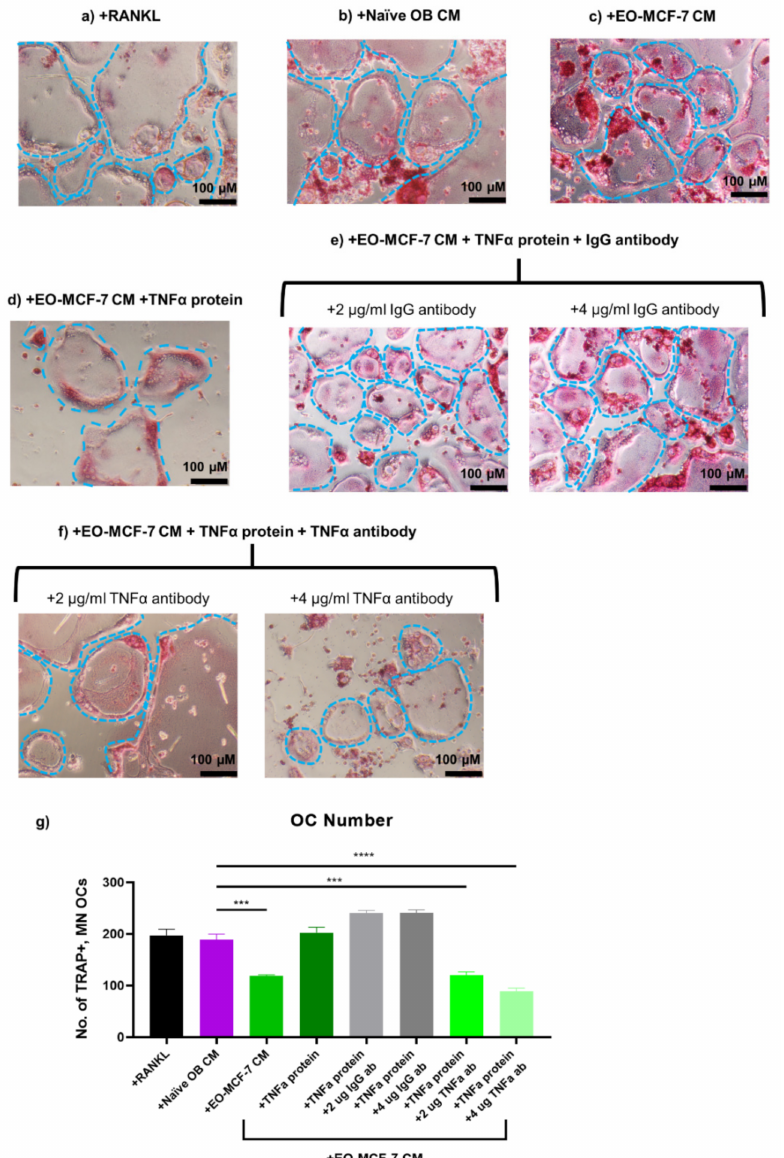
Figure 9. EO-MCF-7-altered Osteoclast Formation can be Modulated by TNF α . RAW 264.7 pre- osteoclasts were cultured in the presence of ( a ) 50 ng/mL exogenous RANKL ( a ) or cultured in the presence of 50 ng/mL exogenous RANKL and exposed either to ( b ) naïve OB CM (control) or ( c ) EO-MCF-7 CM for six days. RAW 264.7 pre-osteoclasts were cultured in the presence of 50 ng/mL exogenous RANKL for six days, then exposed to EO-MCF-7 CM plus either ( d ) recombinant TNF α protein (12 ng/mL) or ( f ) recombinant TNF α protein (12 ng/mL) plus TNF α antibody (2 µ g/mL or 4 µ g/mL). ( e ) RAW 264.7 pre-osteoclasts were exposed to EO-MCF-7 CM in the presence of recombinant TNF α protein (12 ng/mL) plus polyclonal IgG antibody (2 µ g/mL or 4 µ g/mL) in the presence of 50 ng/mL exogenous RANKL for six days as a control. After six days, cultures were stained for tartrate resistant acid phosphatase (TRAP; pink color; blue outlines), a common marker for mature osteoclasts. The number (No.) of TRAP-positive, multinucleated ( ≥ 3 nuclei) mature osteoclasts were quantified for each condition ( g ). Scale = 100 µ M. N = 3. *** p < 0.001; **** p <